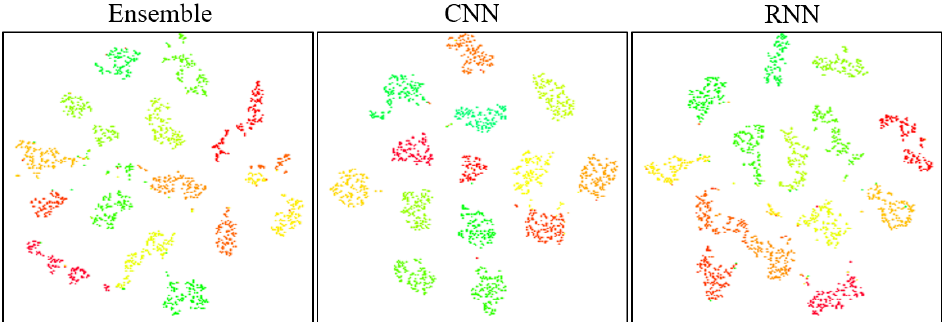
Figure 10. t-SNE plots of embedding vectors of subjects in the unknown known and the unknown unknown test datasets with multi-modal sensing. Each subject is represented by a unique color.